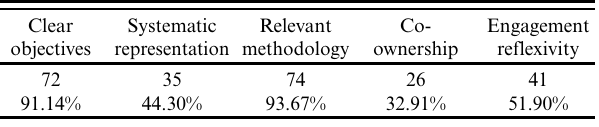
Table 2 . Totals and rates of presence of the five features in the analyzed